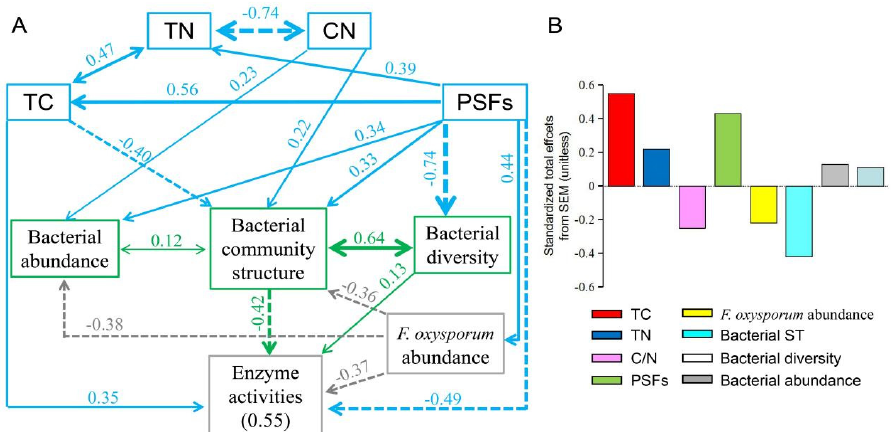
Figure 5. Structural equation modeling (SEM) shows the direct and indirect effects of the bacterial diversity, abundances and community structure on enzyme activities in the soils, in panel ( A ). Panel ( B ) shows the standardized total effects of each individual driver. Continuous and dashed arrows indicate positive ( p < 0.05) and negative ( p < 0.05) relationships, respectively. The blue, green and gray arrows represent the paths of the physiochemical factors, bacterial diversity, abundance and community structure, and the F. oxysporum abundance that affects the enzyme activities, respectively. Numbers following the included variables show the explained percentage of its variance by its predictors. The numbers on the arrows are the standardized path coefficients. The models fit the data well. Model fits are given in Table S4. TC, soil total carbon; TN, soil total nitrogen; C/N, C, N ratio; PSFs, the composition of soil particle-size fractions; Bacterial ST, bacterial community structure.